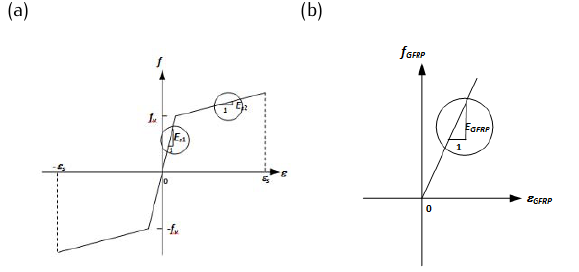
Figure 9. (a) Stress- strain curve for Steel; (b) Stress strain curve for GFRP